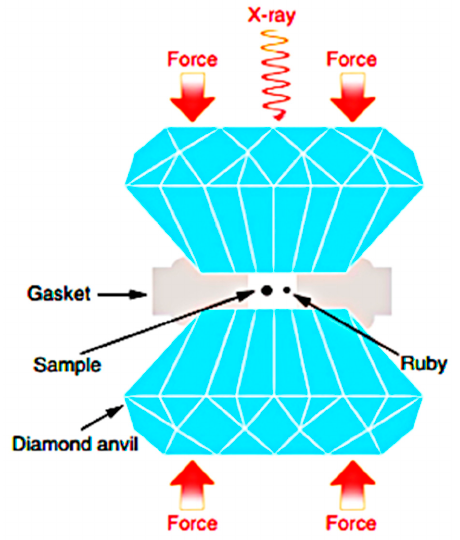
Figure 4. Schematic of the diamond anvil cell (DAC).